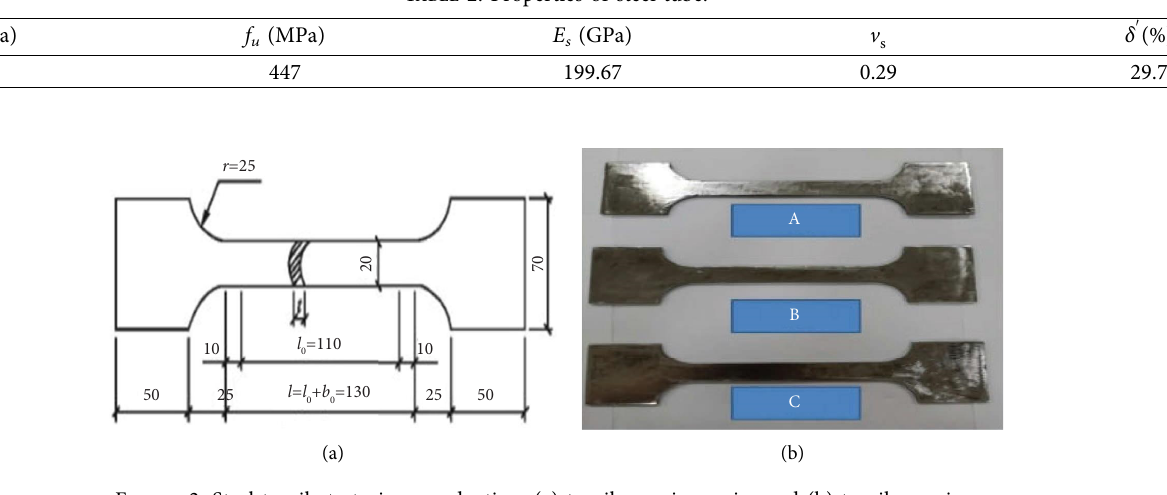
Figure 2: Steel tensile test piece production: (a) tensile specimen size and (b) tensile